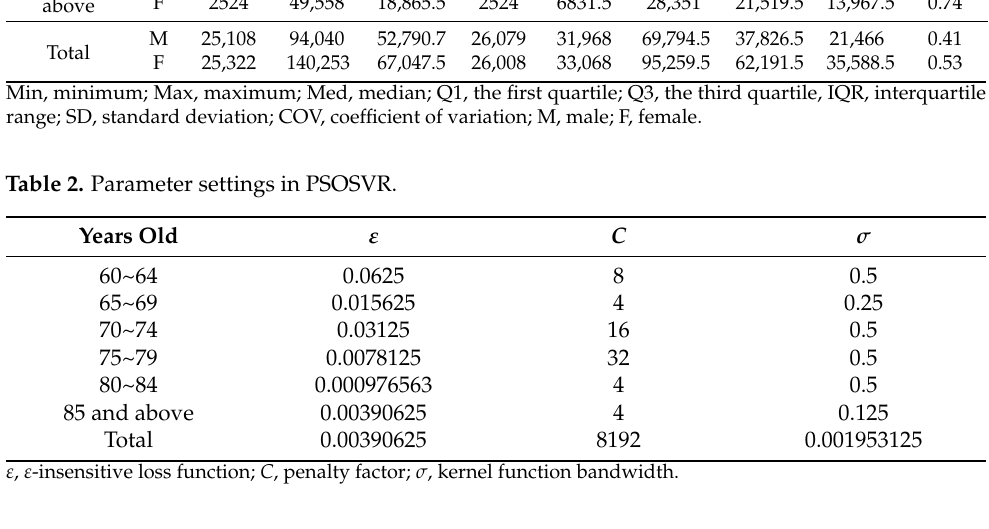
Table 3. Number of neurons and parameter settings for proposed